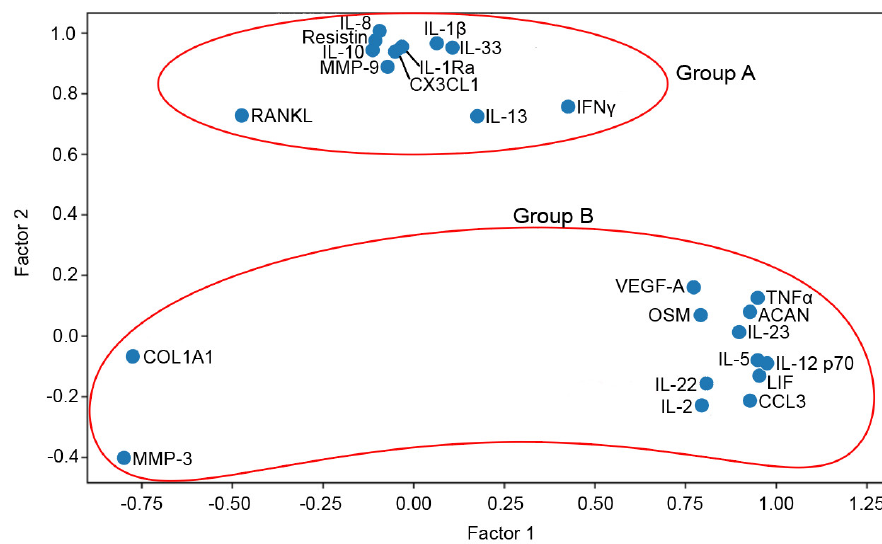
Figure 4. Subgroups of investigated cytokines ( n = 24) after principal component analysis. The factor analysis suggested 2 main factors one containing 11 and other 13 cytokines. With the help of the factor analysis, we were able to reduce the number of variables.